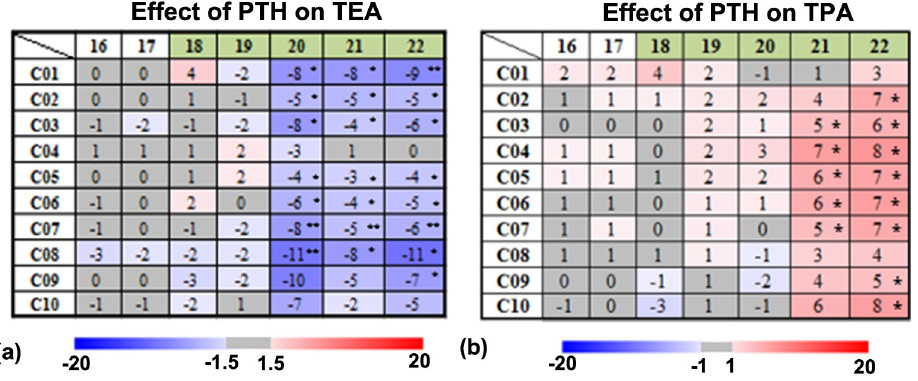
Fig 4. Longitudinal effects of PTH treatment on the tibial TEA and TPA in the spatiotemporal space. The data are presented as the mean relative percentage difference ( δ D% j ) between the Wild and WildPTH groups ( � p < 0.05, �� p <